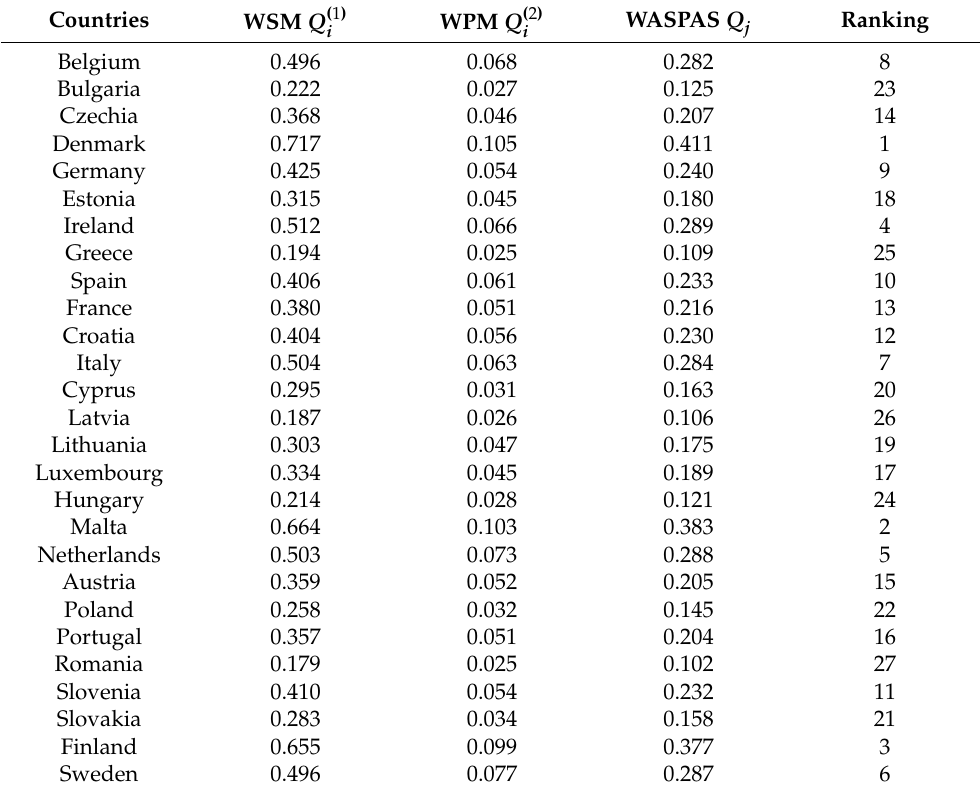
Table 7. Values for WSM, WPM, and WASPAS indicators as well as the ranking of individual EU